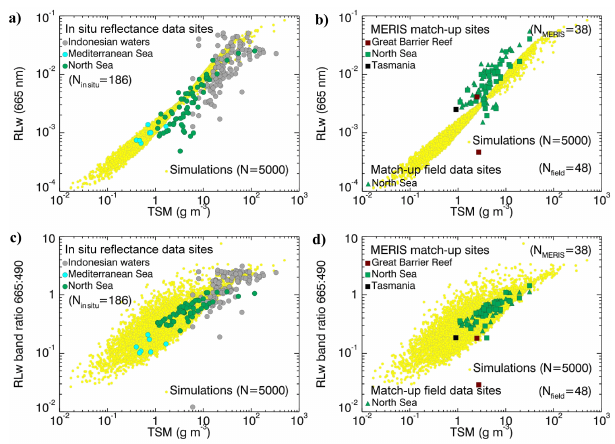
Figure 27. The relationships TSM vs. RLw(665) and TSM vs. RLw band ratio 665:490 in the in situ reflectance data set (non-yellow circles) plotted respectively in panels (a) and (c) , in the MERIS and match-up field data sets (squares and triangles) respectively in panels (b) and (d) , and in the simulated data set (yellow circles) in panels (a–d)